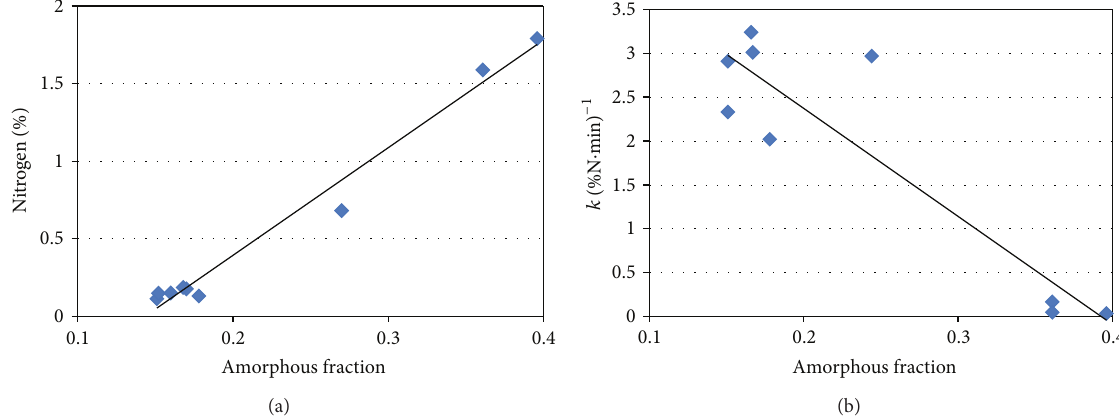
Figure 5: Nitrogen percentage (a) and kinetic constant of the pseudo-second-order model (b) versus amorphous fraction of